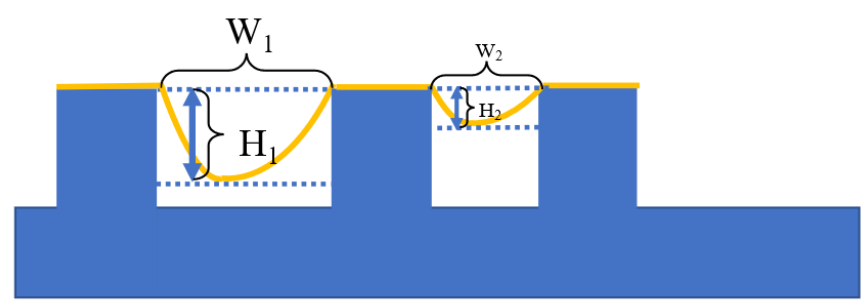
Figure 4. The principle of tip characterizer to reconstruct the AFM tip depth to width ratio.